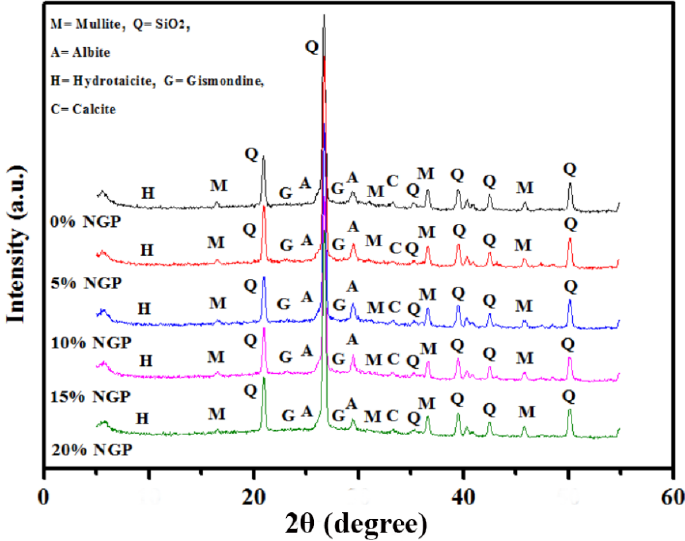
Figure 10. XRD patterns of AAM with various BGWNP contents.